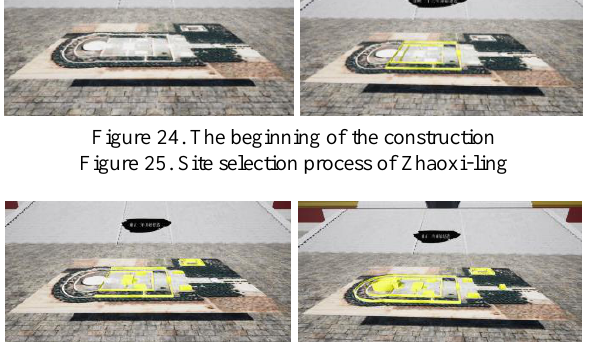
Figure 26. Zhaoxi-ling in Qianlong Period Figure 27. Zhaoxi-ling in Yongzheng Period